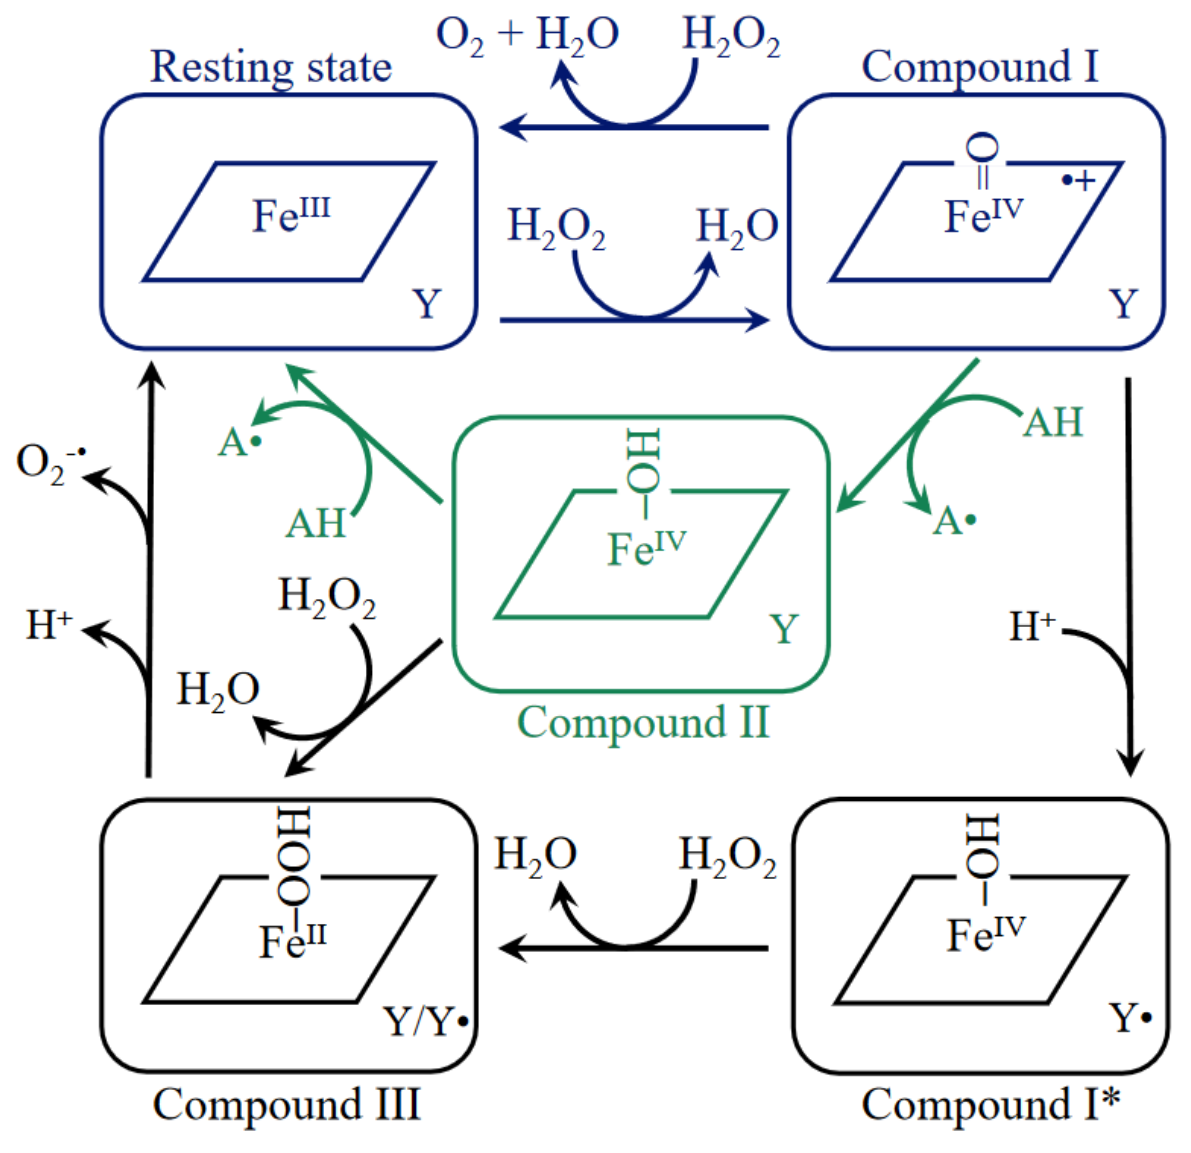
Figure 6. Scheme of catalase reactions. Shown in blue are the two steps of the catalase reaction which take place at a high rate; in green, the peroxidatic reaction which occurs at a much slower rate with reducing substrates (AH) at a much higher concentration than H 2 O 2 ; in black, the formation of intermediates that inhibit the catalatic reaction. The parallelogram denotes the porphyrin ring and Y a Tyr in the protein that can form a radical, Y • .